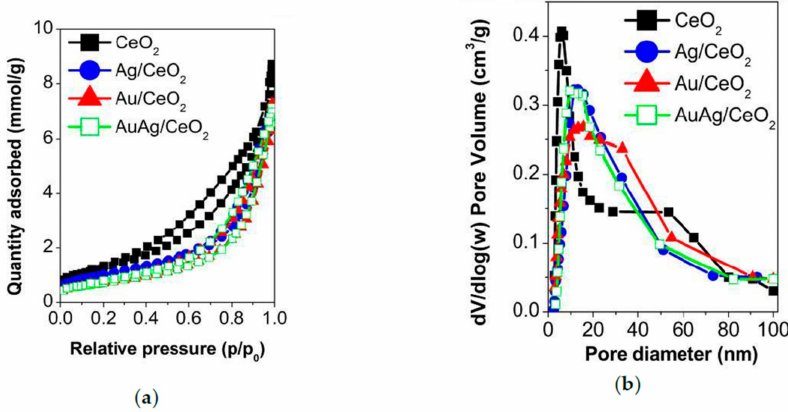
Figure 3. ( a ) N 2 adsorption-desorption isotherms and ( b ) Barrett, Joyner and Halenda pore size distribution of the investigated